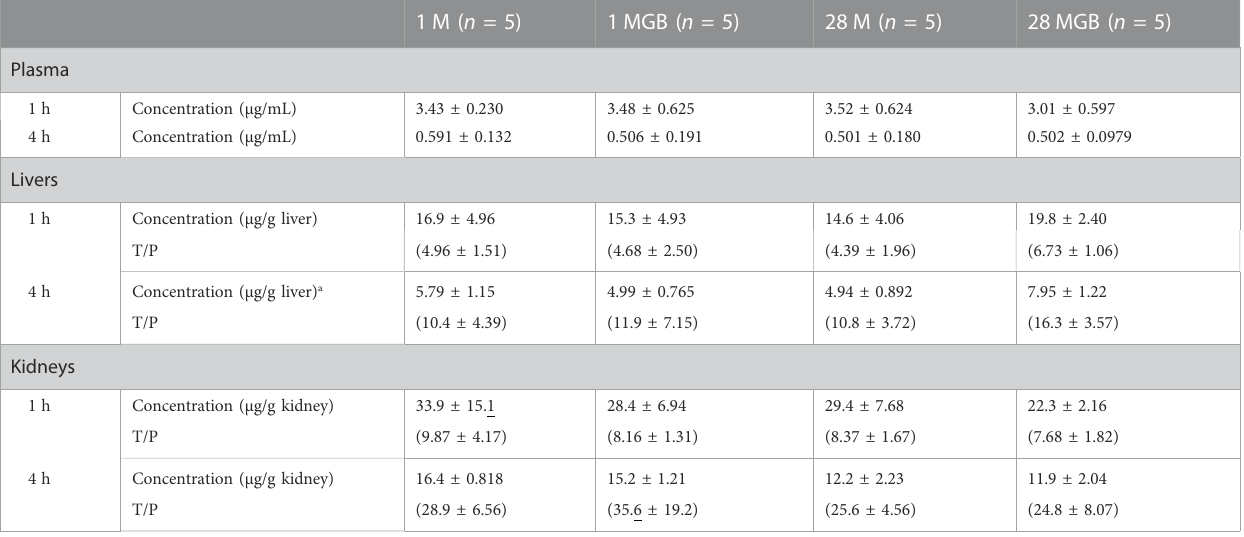
The values in parenthesis represent the tissue to plasma (T/P) ratios. a 28 MGB, was signi fi cantly different ( p < 0.05) from other